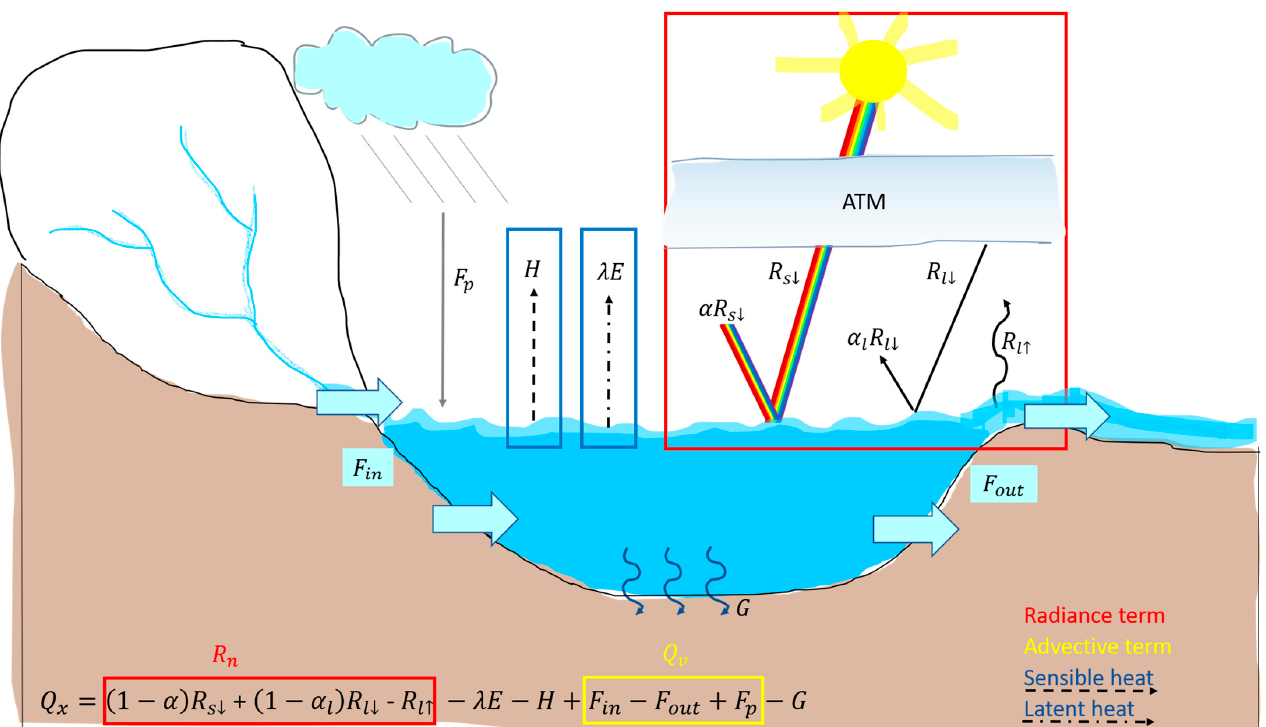
Figure 1. Representation of all terms of the heat balance in a water body.